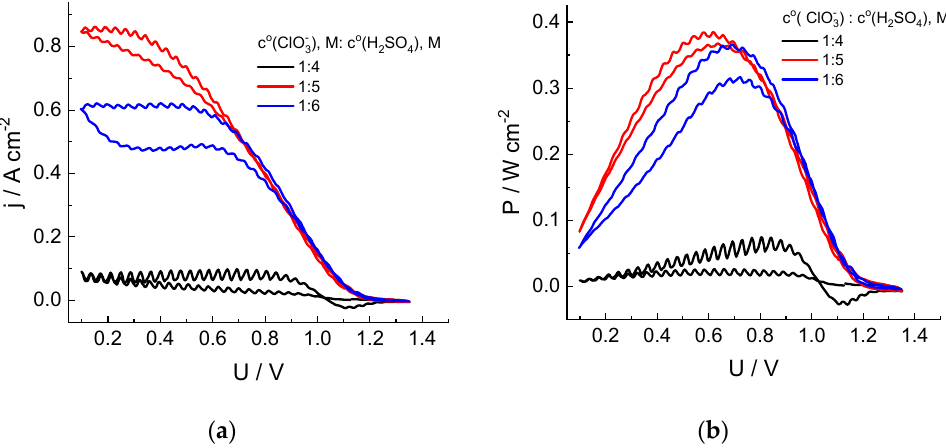
Figure 2. Dependences of the cathodic current density ( a ) and specific power ( b ) of the cell discharge on its voltage in the course of the second cycle of its sweep from OCV to 0.1 V and back for hydrogen-chlorate MEA. Catholyte composition: 1 M NaClO 3 + x M H 2 SO 4 (x = 4, 5 or 6). See Figure 1 for additional information.